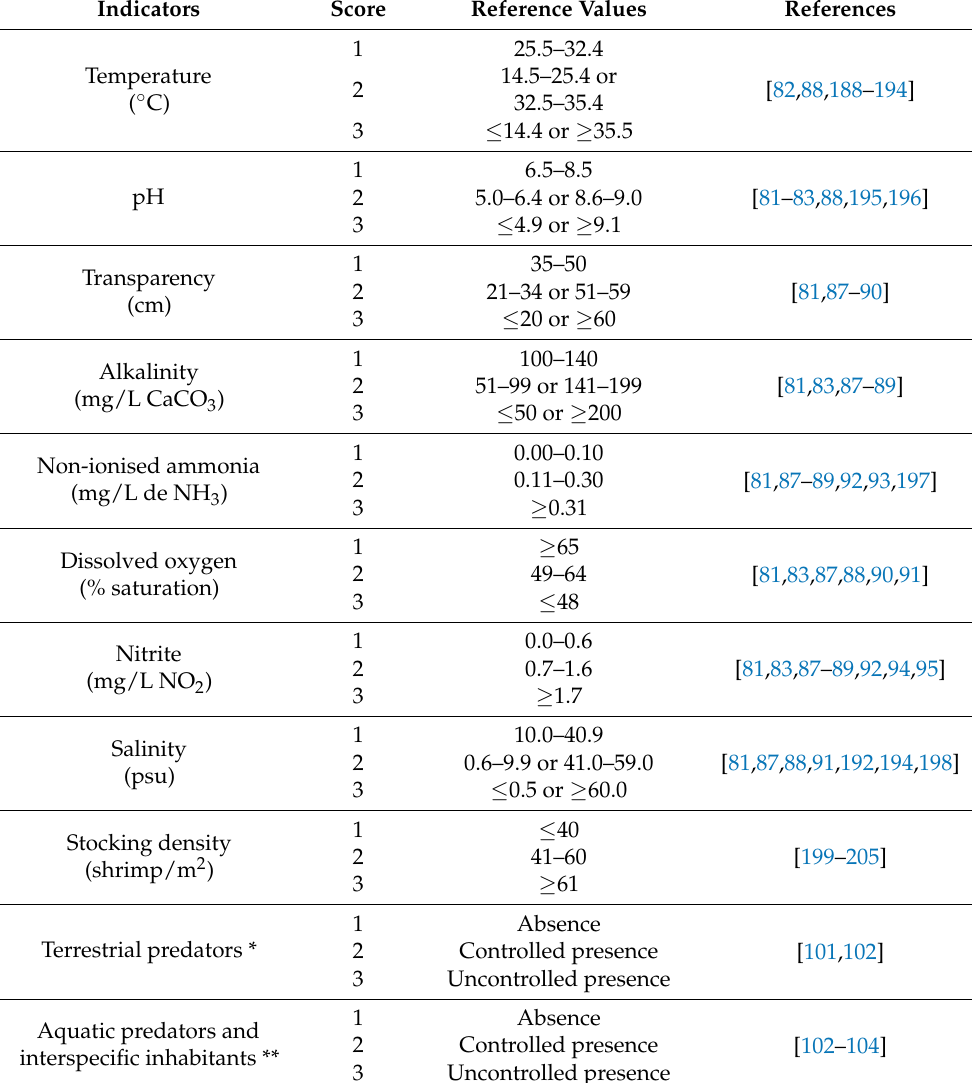
Table 11. Environmental indicators for juvenile and adult Penaeus vannamei. It is recommended that postlarvae are previously acclimatised in ponds for 10 to 15 min for every degree of temperature difference and salinity unit (81; 149) and at least 60 min per different 0.5 pH unit (81;